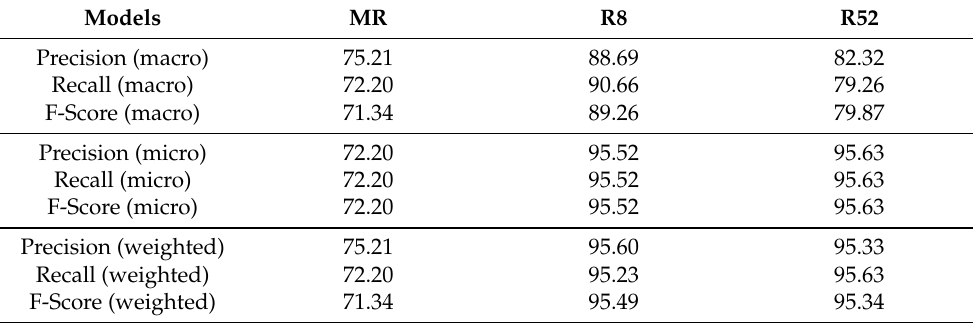
Table 5. Performance of Bi-GRU+Attn for various evaluation metrics.